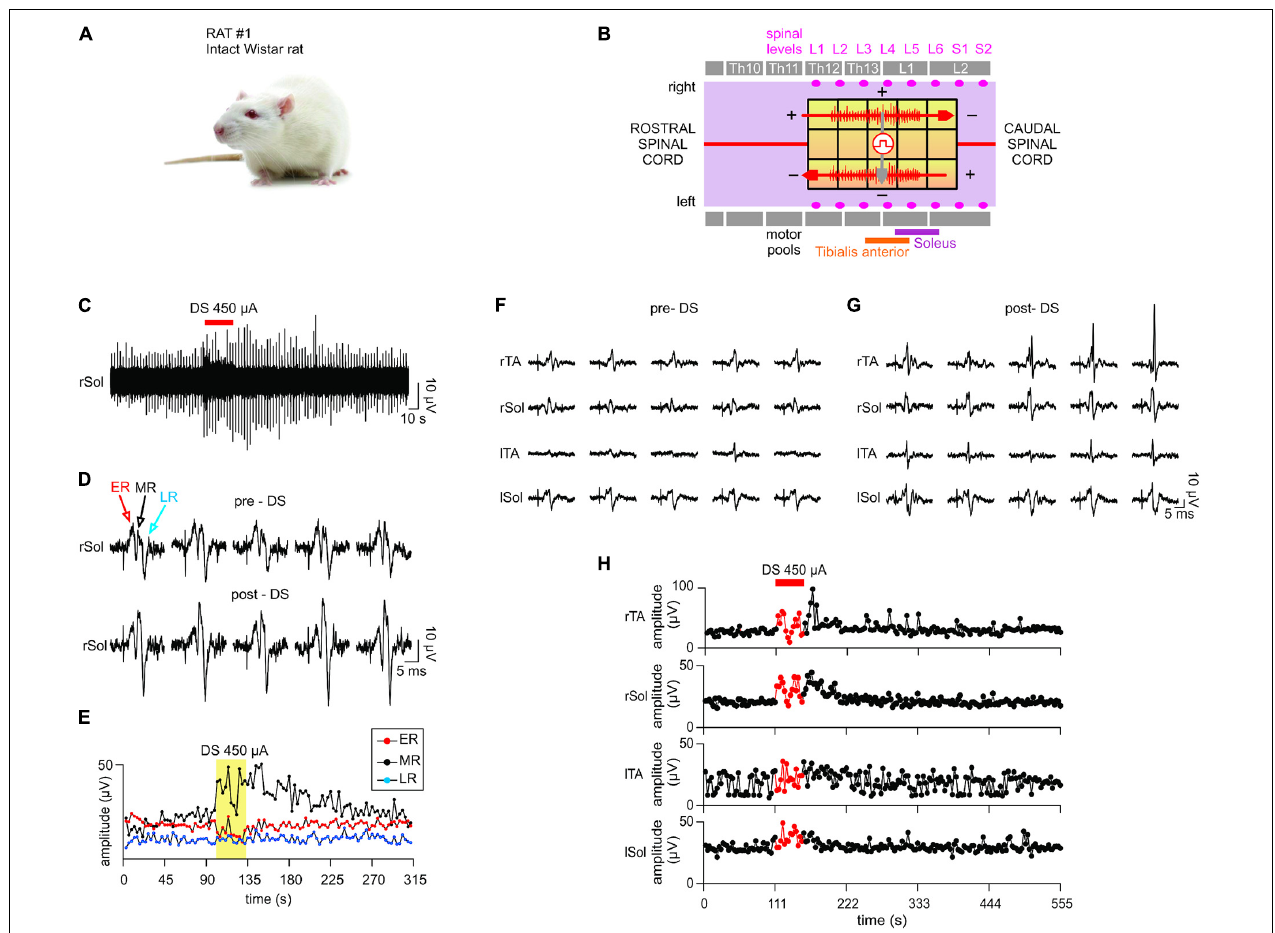
FIGURE 8 | In vivo test results I. The stimulator prototype delivers a DS protocol and increases excitability of an intact spinal cord of an animal subject during and post protocol delivery. (A) Animal type used in this experiment. (B) The diagram of the epidural electrode array shows the electrodes to which stimulation was delivered. Two DS stimuli were delivered simultaneously in a bipolar configuration (red arrows) using the stimulator prototype. An auxiliary stimulation “test pulse” is delivered in the middle of the spinal cord (gray arrow) to test the responsiveness of the motor outputs. The test pulse intensity is adjusted to evoke consistent electromyography (EMG) responses in all muscles. (C) DS protocol increases the responsiveness of the motor outputs to test pulses at the right Sol muscle. (D) Five evoked response plots were randomly selected from the pre-DS and post-DS recording section to illustrate the resulting range of amplitudes. (E) EMG response levels at the right Sol are quantified over time of the experiment. Middle response notably increases due to DS protocol. (F–H) The test pulse intensity is reduced to emulate a decreased spinal cord connectivity occurring in cases of spinal cord injury. (F,G) While pre-DS responses are relatively decreased or absent, post-DS responses are restored in all muscles. (H) Sustained increases of Middle Responses are noted in motor outputs of all four EMG